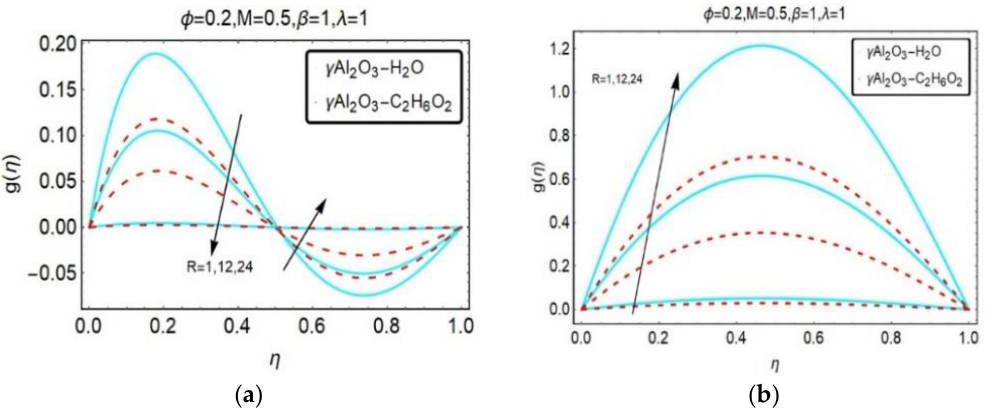
Figure 11. Influence of R on g ( η ) for ( a ) S > 0 and ( b ) S < 0. Energies 2020 , 13 , x FOR PEER REVIEW